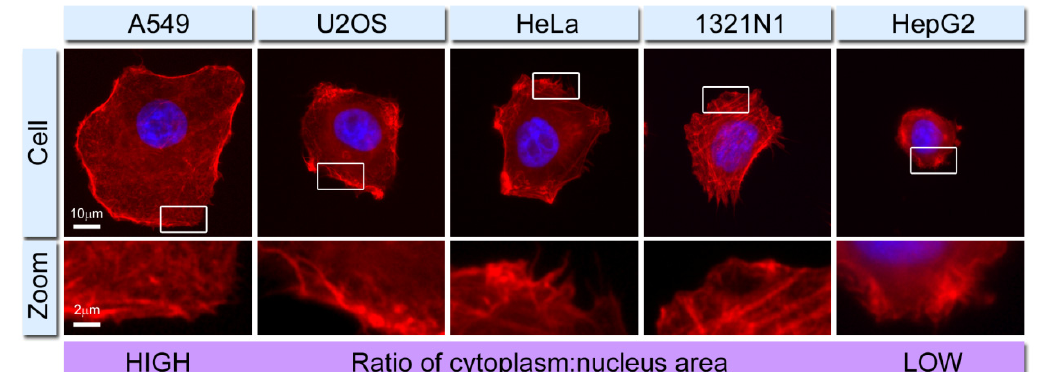
Figure 1. Fluorescence imaging of human cell lines used to study actin cytoskeleton